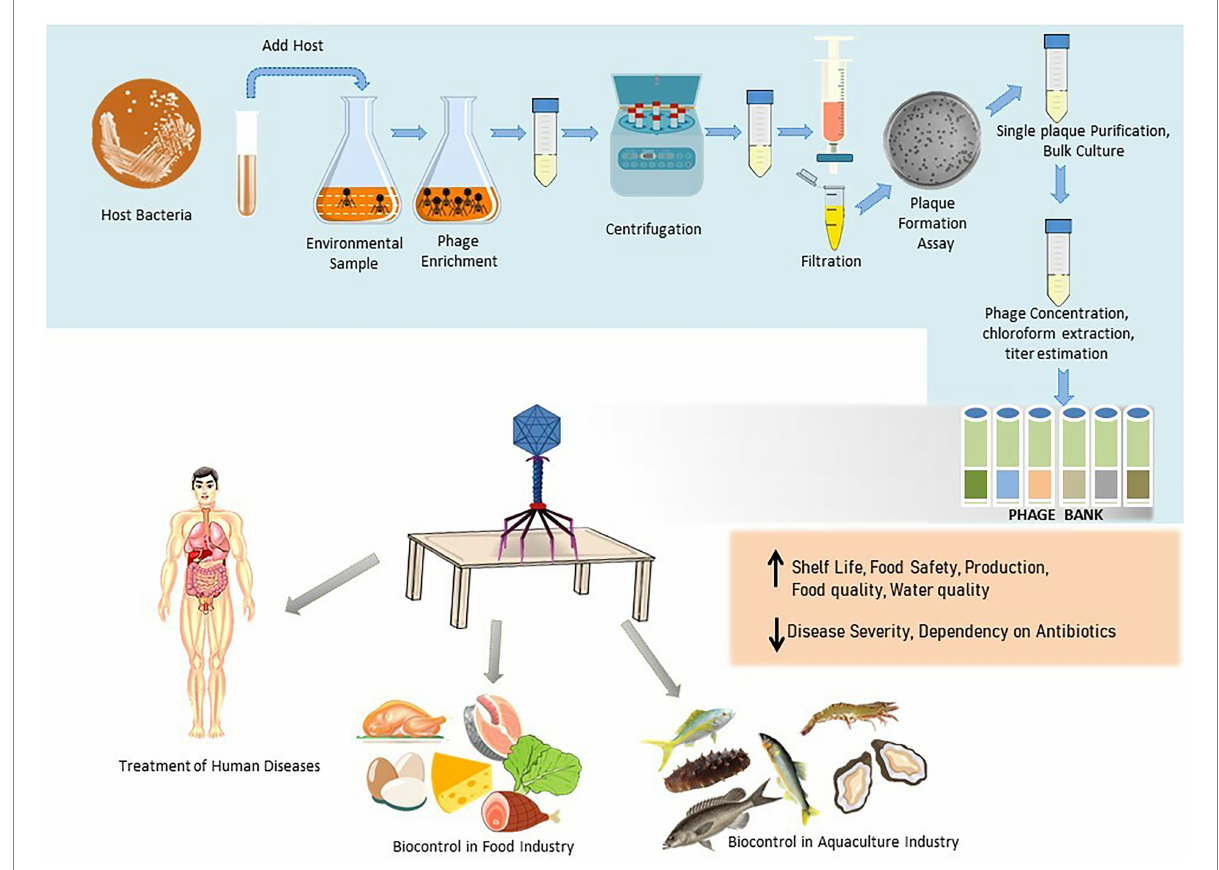
FIGURE 1 Schematic illustration of the phage isolation, purification, preservation, and their applications in therapy and biocontrol in food industry and